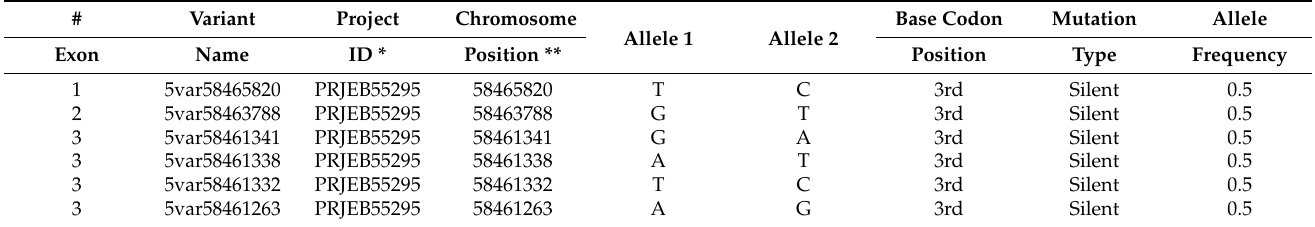
Table 1. Analysis of potential amino acid substitutions caused by SNPs in the coding